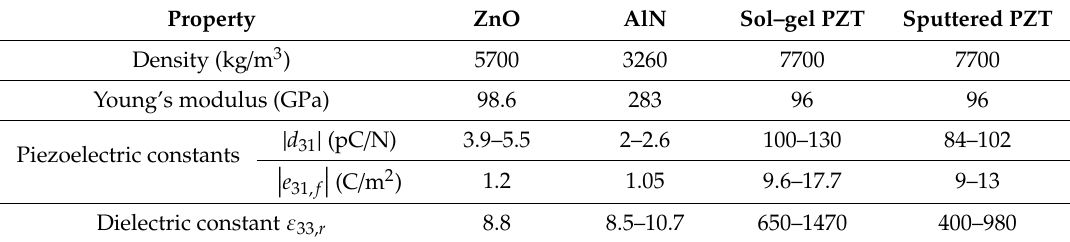
Table 4. Material properties of commonly used piezoelectric thin films